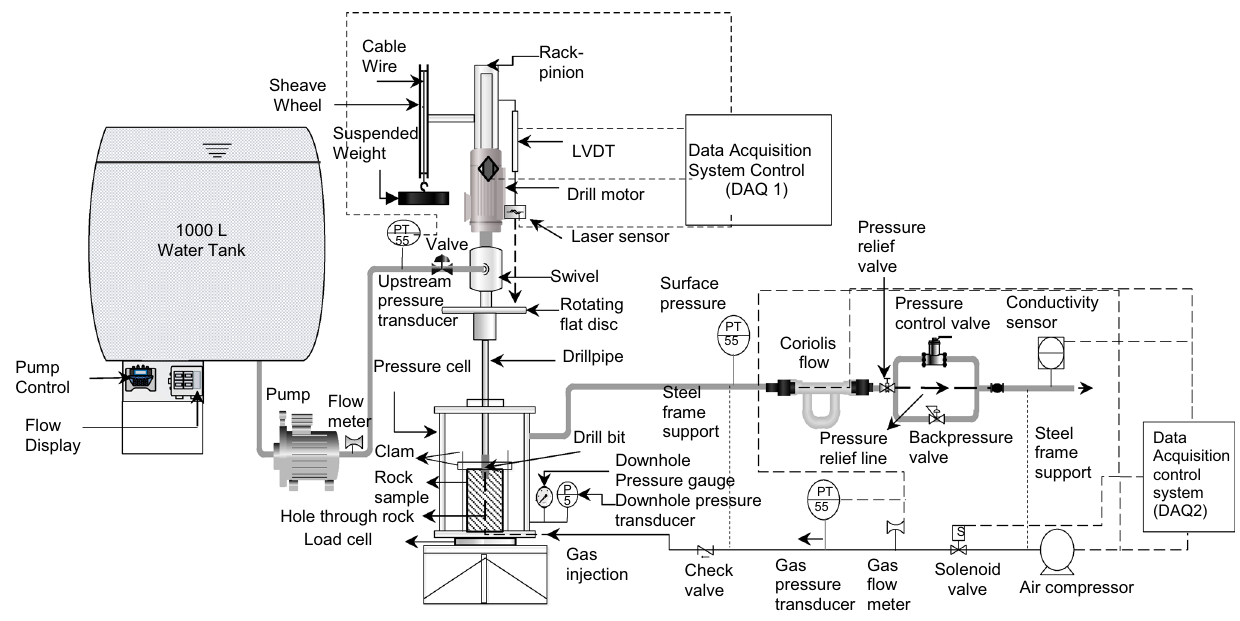
Fig. 4 Kick experiment process flow